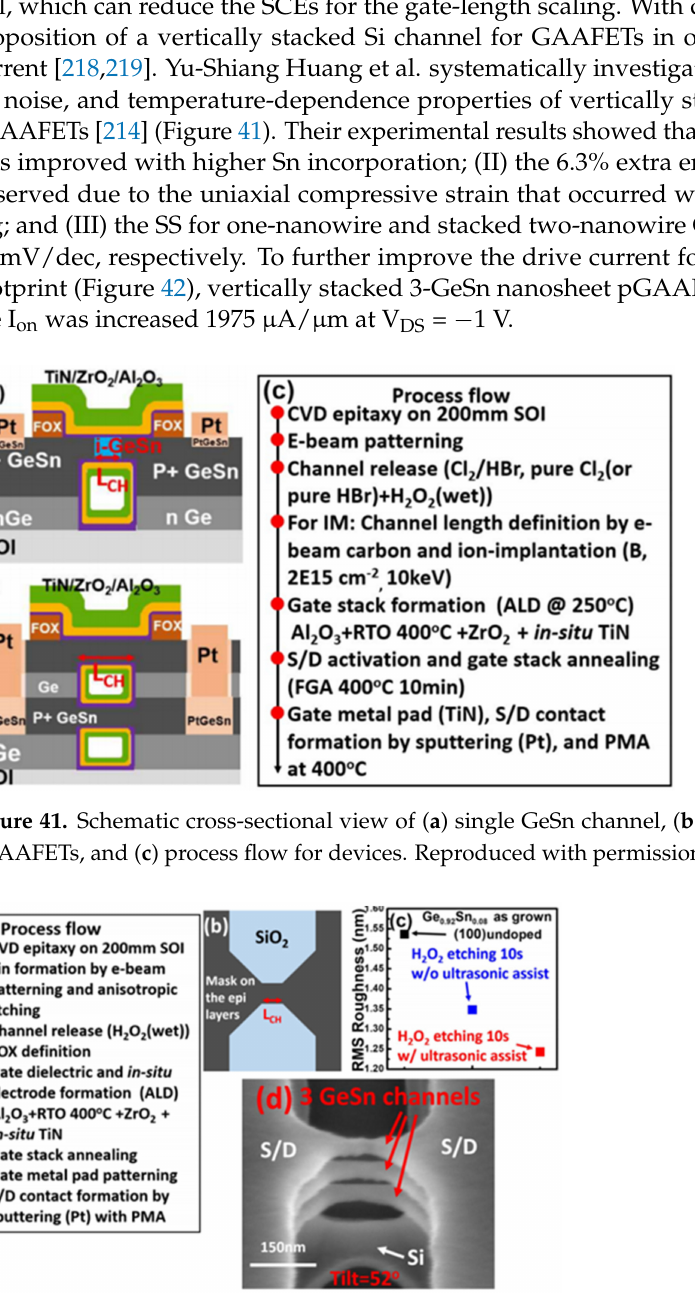
Figure 42. ( a ) Process flow for vertically stacked 3-GeSn nanosheet pGAAFETs; ( b ) top view after the fin formation; ( c ) RMS value for as-grown GeSn; ( d ) SEM image of stacked 3-GeSn nanosheets. Reproduced with permission from [91], IEEE,